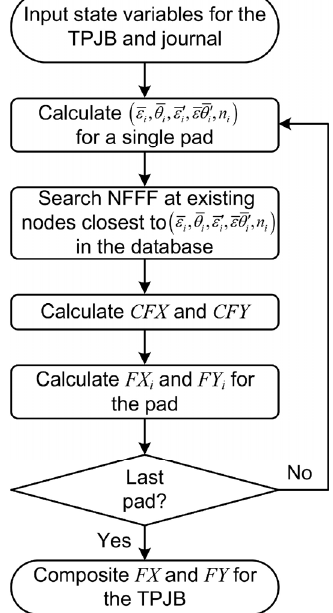
Fig. 4 Flow chart for accessing the NFFF database.